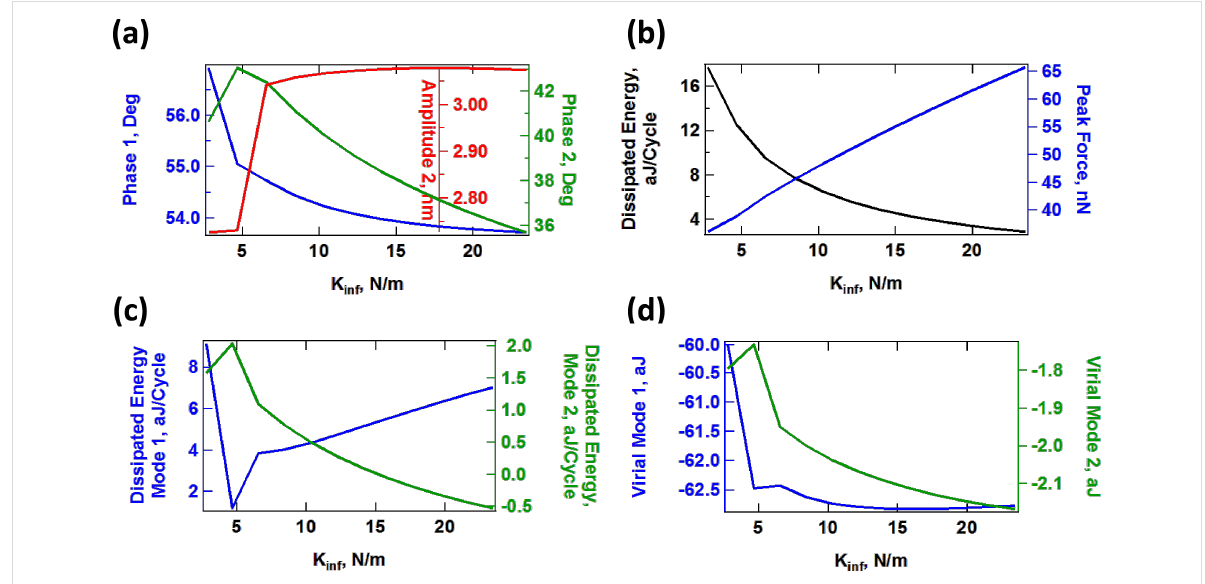
Figure 11: Effect of the SLS parameter K inf on tip–sample interactions and cantilever response. (a) First and second mode phase, and second mode amplitude; (b) dissipated energy calculated from the hysteresis loop of the tip–sample force trajectory and peak impact force; (c) calculated dissi- pated energy from Equation 5 for the first and second eigenmodes; (d) virial for the first and second eigenmodes. Note that the peak impact force is the largest repulsive force observed over fifteen tip–sample impacts (successive impacts differ, as illustrated in Figure 7c). The parameters other than K inf are the same used to construct Figure 10. The axes are color coded in all cases. The kinks in some of the traces correspond to transitions between dynamic regimes, in some of which the tip skips a tip–sample impact with different frequencies (for example, in one regime the tip may impact the sample every fundamental oscillation, while in another regime the tip may skip every sixth impact